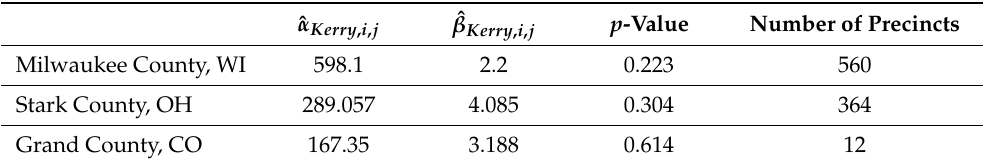
Table 4. Maximum Likelihood Estimates and Goodness of Fit Test Results for Vote Counts for Selected Counties in 2004 US Presidential Election—Senator John F. Kerry. p -values above 0.05 indicate conformance to discrete Weibull distribution. ˆ α Kerry , i , j ˆ β Kerry , i , j p